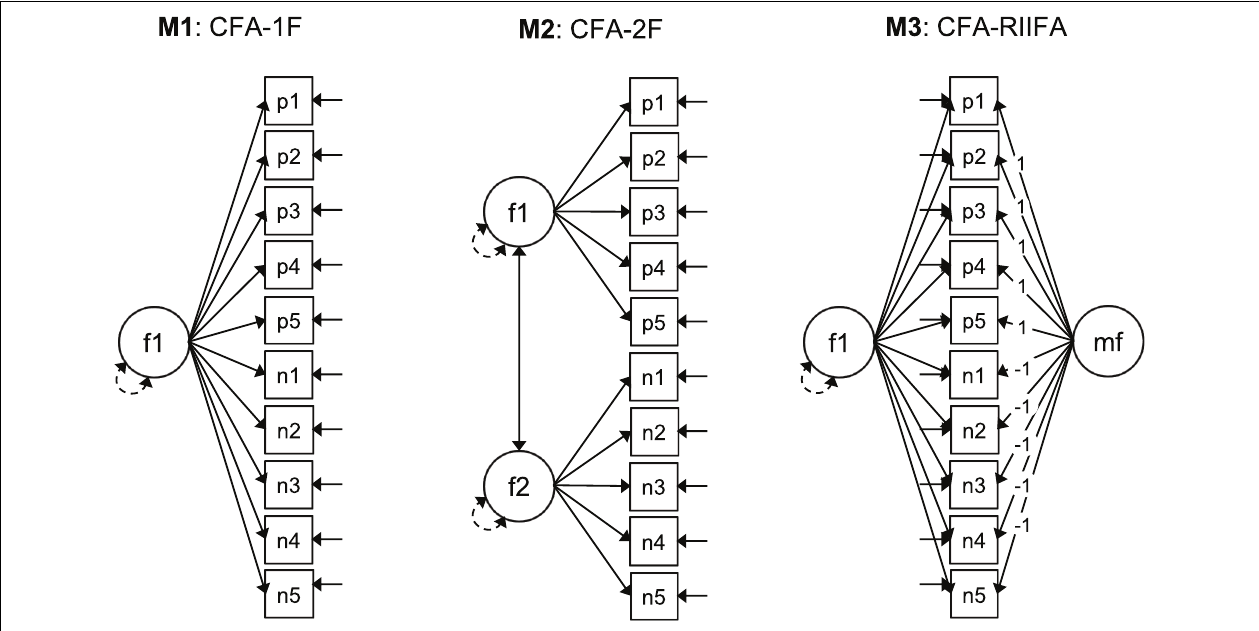
FIGURE 3 | Factorial models examined for the RSES scores. CFA, confirmatory factor analysis; #F, number of substantive factors; RIIFA, random intercept item factor analysis; f1, f2, substantive factors; mf, method factor; p1–p5, positive items; n1–n5, negative items recoded. Squares represent observed variables. Circles represent latent variables. Unidirectional arrows linking circles and rectangles represent factor loadings. Bidirectional arrows linking the circles represent the factor covariances and correlations. Bidirectional arrows connecting a single circle represent the factor variances. Full unidirectional arrows linked to the squares represent item